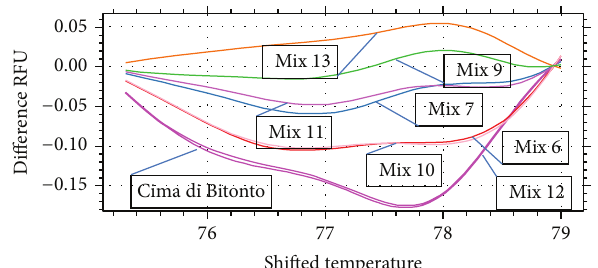
Figure 4: Normalized and temperature-shifted difference curve of different commercial samples (mixes 11 and 12), Terra di Bari oils (monovarietal Cima di Bitonto oil and mixes 6, 7, 9, 10), and non- Terra di Bari olive oil (mix 13).